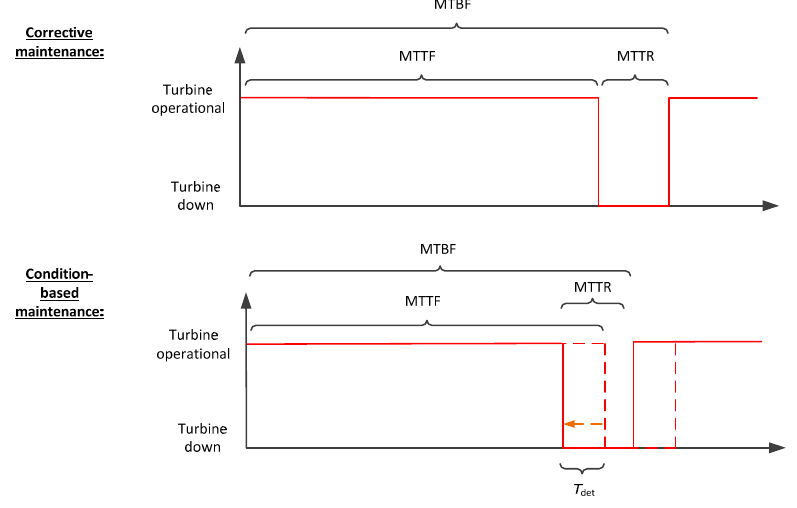
Figure 10. Illustration of the effect of CBM on the mean time between maintenance tasks.